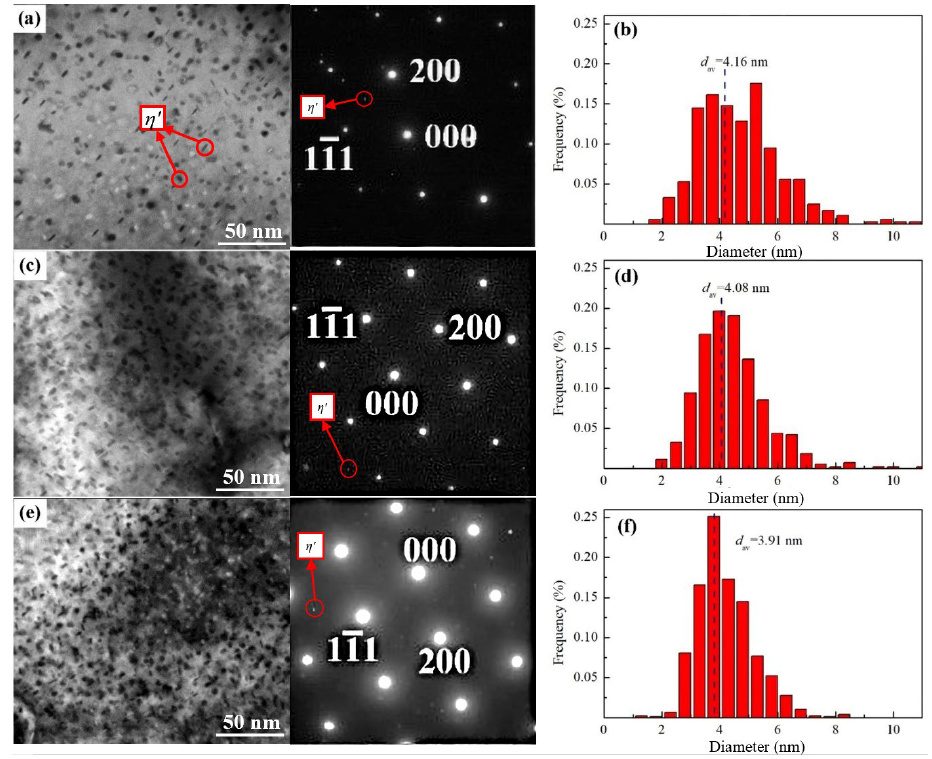
Figure 6. TEM images of Al-5Zn-2.6Mg-xCu alloys at 393 K peak aging: ( a ) x = 0.24 wt.%, ( c ) x = 0.43 wt.%, and ( e ) x = 0.91wt.% and ( b , d , f ) corresponding size distribution of the precipitates.